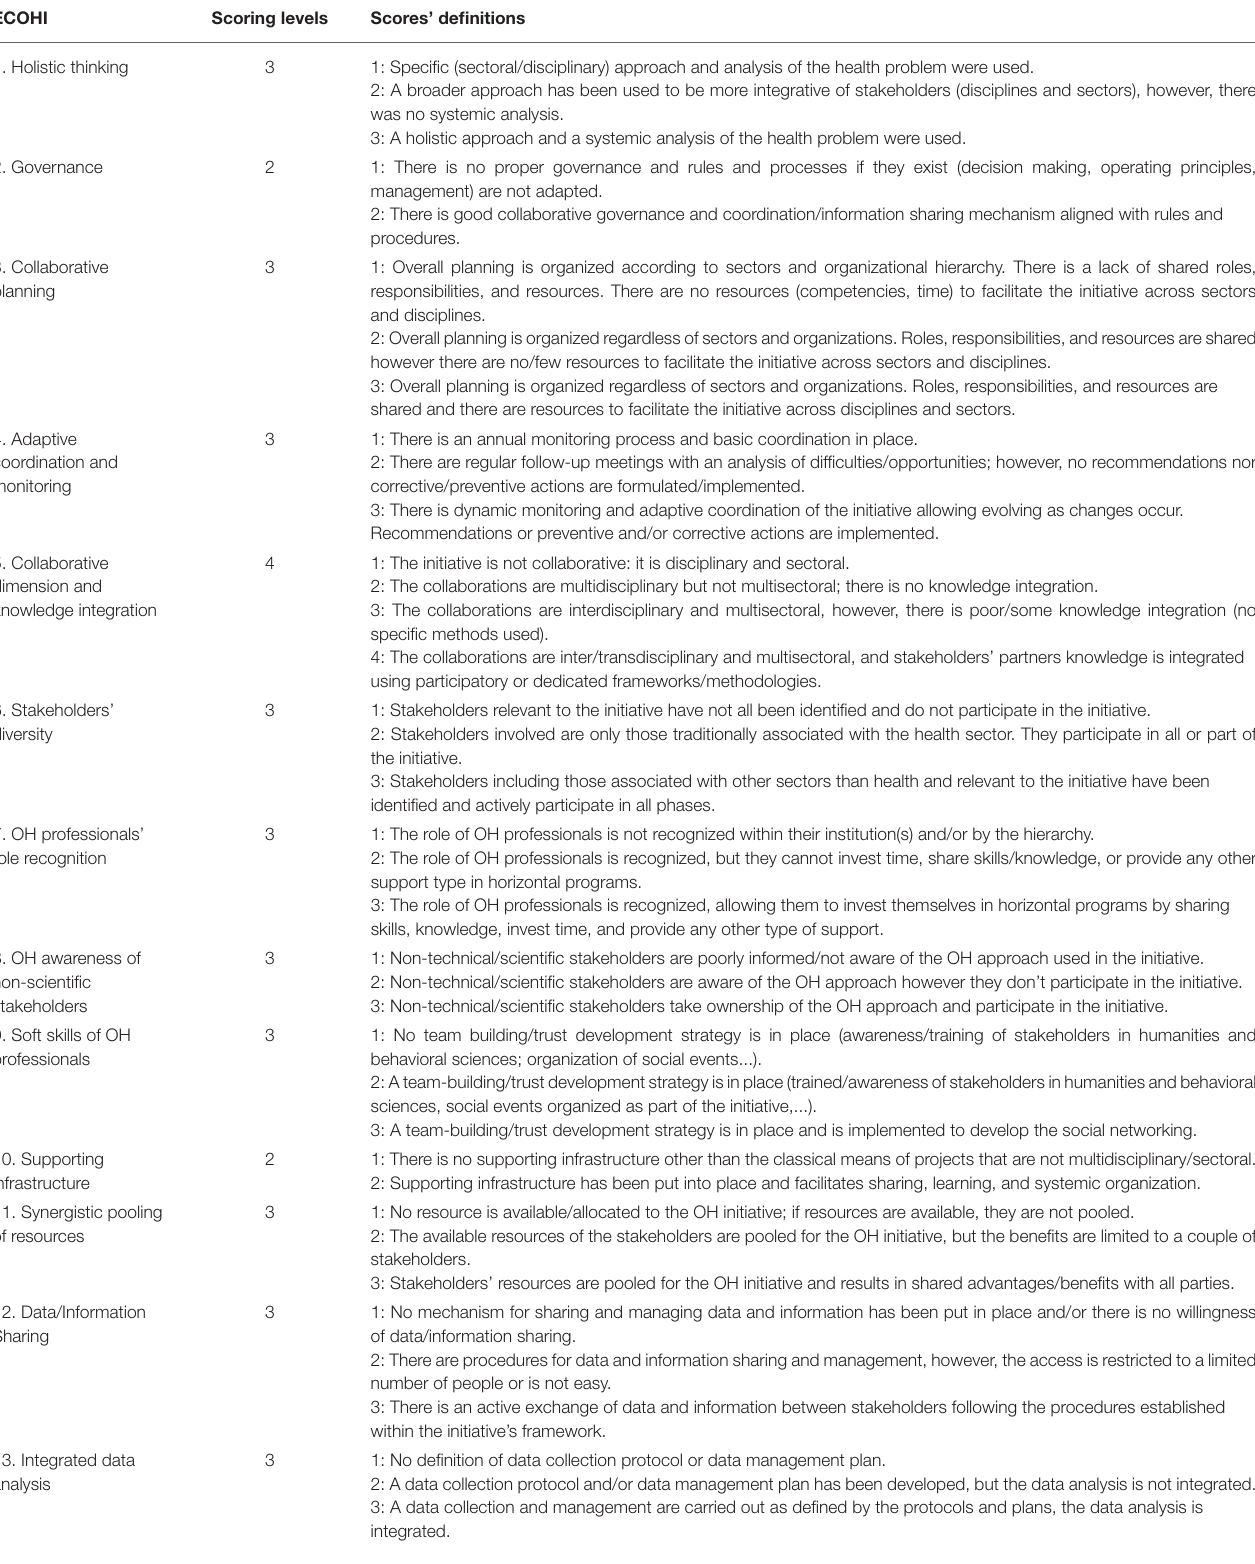
TABLE 3 | Definition of the scores for each Evaluation Criteria for OH Implementation (ECOHI).